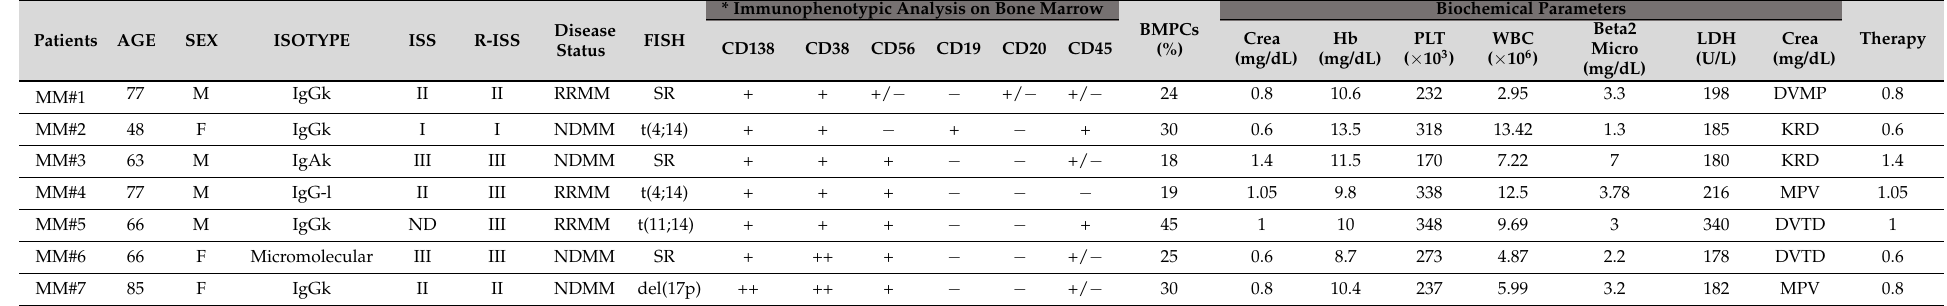
Table 1. Patients’